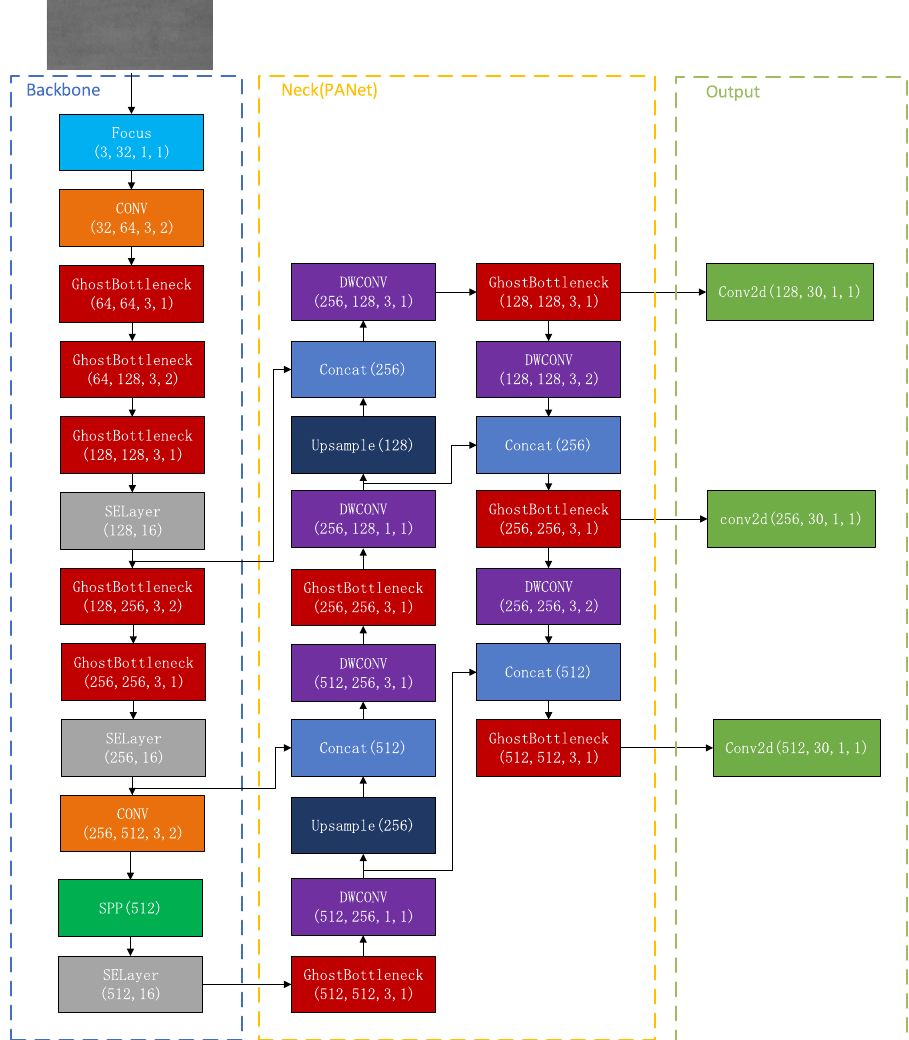
Figure 3. Modified Yolov5s structure (PB-Yolov5s).